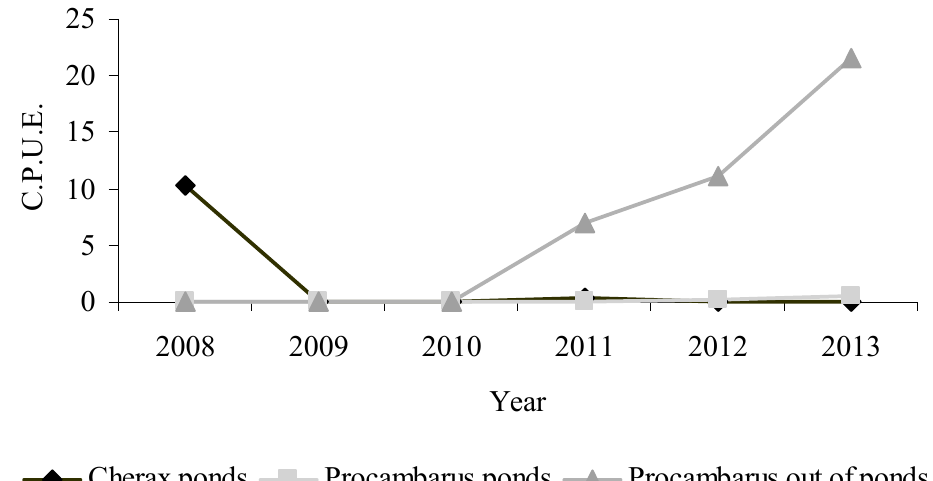
Figure 2. Trend of Catch per Unit Effort (CPUE) of Cherax destructor and Procambarus clarkii from 2008 to 2013.